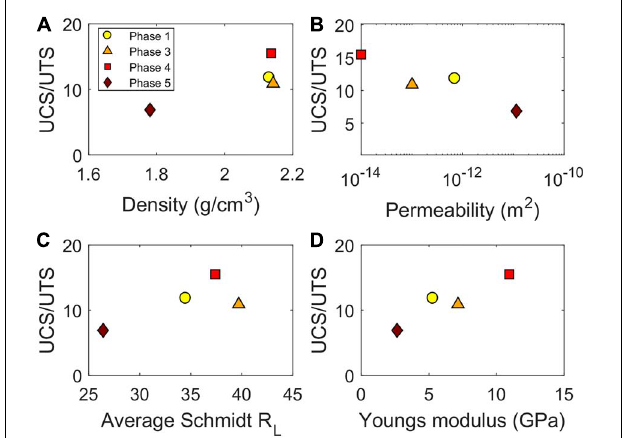
FIGURE 10 | (A) UCS/UTS ratio as a function of density; (B) UCS/UTS ratio as a function of permeability; (C) UCS/UTS ratio as a function of average Schmidt hammer rebound value ( R L ); and (D) UCS/UTS ratio as a function of Young’s modulus. Phase averages shown in each case. A higher UCS/UTS ratio correlates to lower permeabilities, higher Schmidt hammer rebound values, and higher Young’s modulus